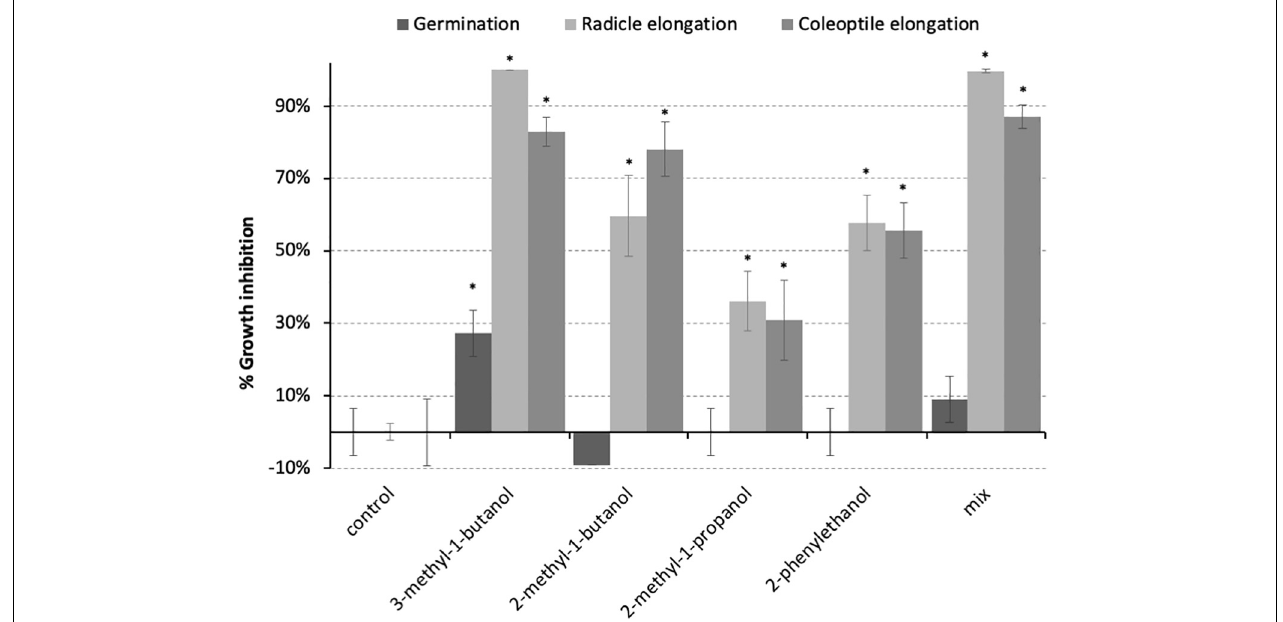
FIGURE 2 | Inhibition of wheat seedling development by the predominant VOCs produced by P. nodorum . The bars represent the inhibitory activity on the developmental stage. 3-methyl-1-butanol, 2-methyl-1-butanol, 2-methyl-1-propanol, and 2-phenylethanol were tested at 1 mM. Error bars show the standard deviation and asterisks indicate statistically significant differences compared to the control ( p < 0.05).